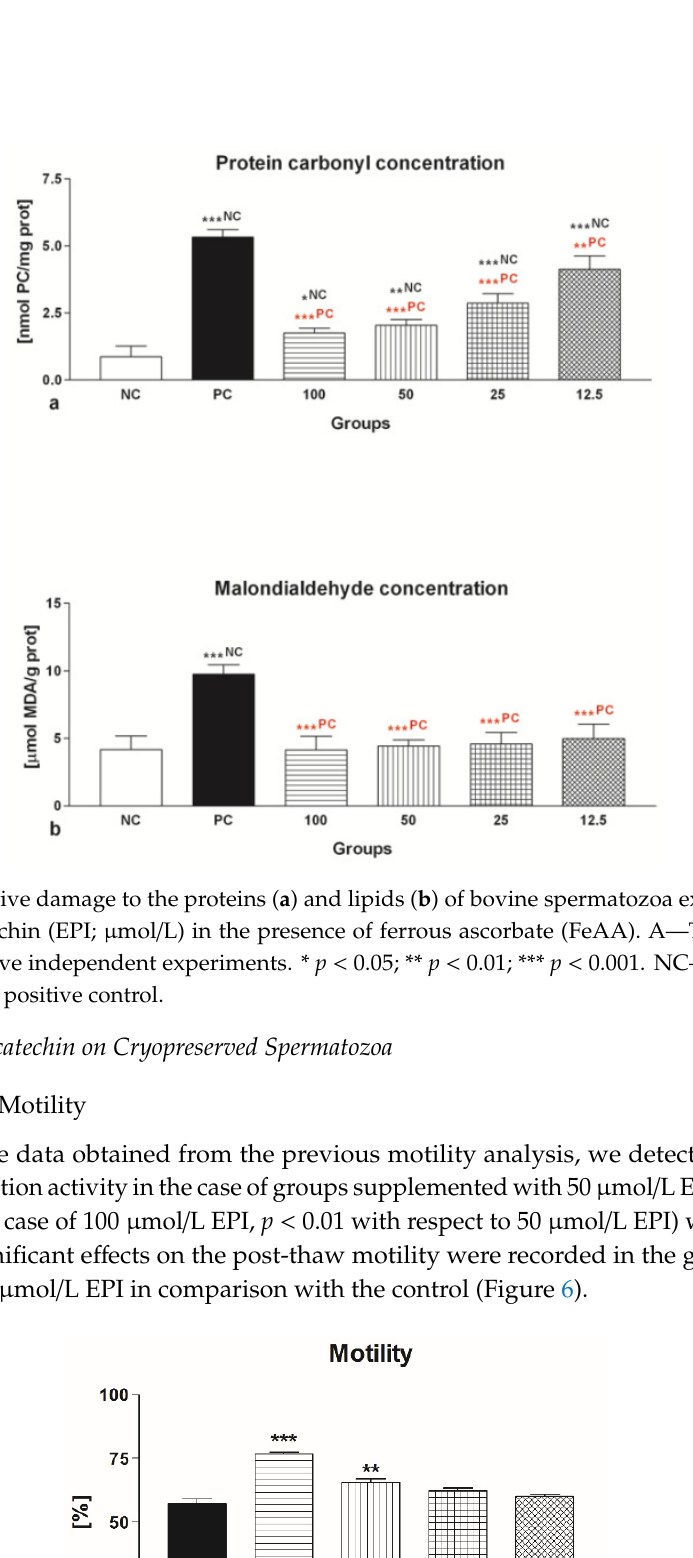
6 of 18 Figure 4. DNA fragmentation of bovine spermatozoa exposed to four doses of epicatechin (EPI; μ mol/L) in the presence of ferrous ascorbate (FeAA). The data were obtained from five independent experiments. * p < 0.05; ** p < 0.01; *** p < 0.001. NC—vs. negative control; PC—vs. positive control. 2.1.5. Oxidative Damage The selected colorimetric analyses revealed a significant increase ( p < 0.001) in the content of protein carbonyls (Figure 5a), as well as malondialdehyde (MDA; Figure 5b) in all groups exposed to FeAA in comparison to NC. The protective effects of EPI on the protein and lipid biomolecules showed to be significant. The decrease of the number of protein carbonyls was particularly pronounced in the case of 25 μ mol/L